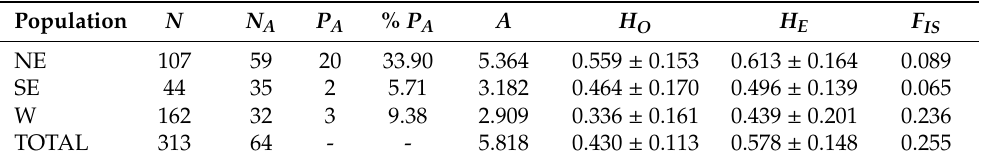
Table 5. Indicators of genetic variety of the Northeastern (NE), Southeastern (SE), and Western (W) populations of European mink, based on 11 microsatellite loci